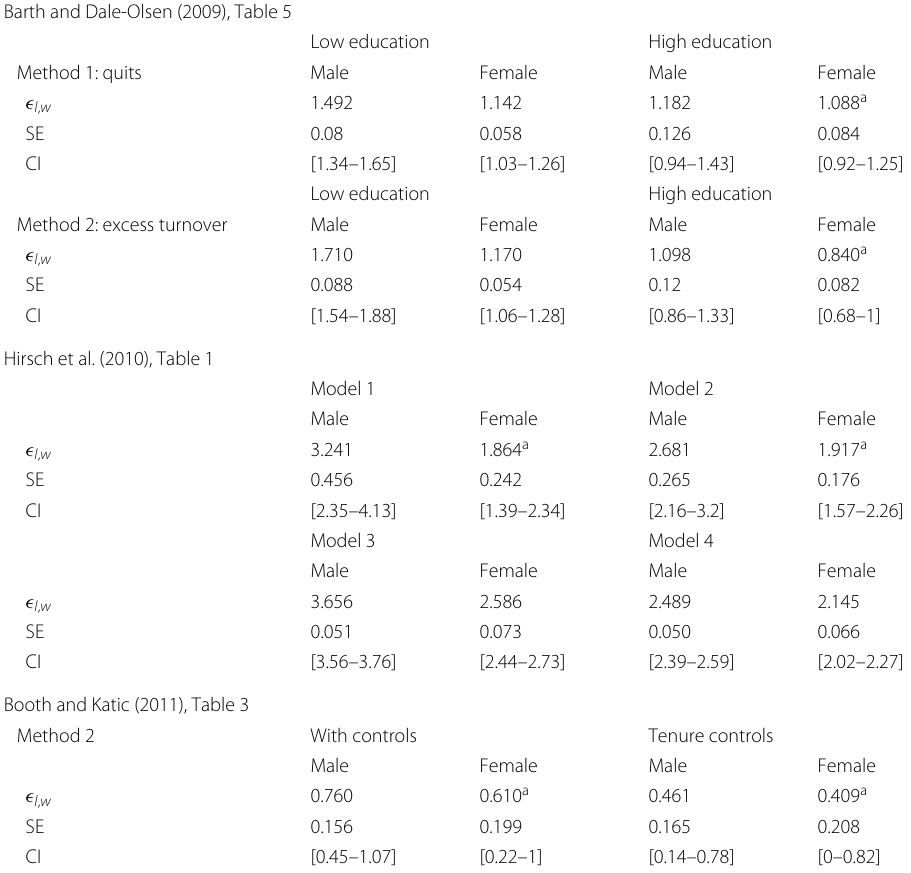
Table 7 Confidence intervals of male and female elasticities—implications for three studies Barth and Dale-Olsen (2009), Table 5 Low